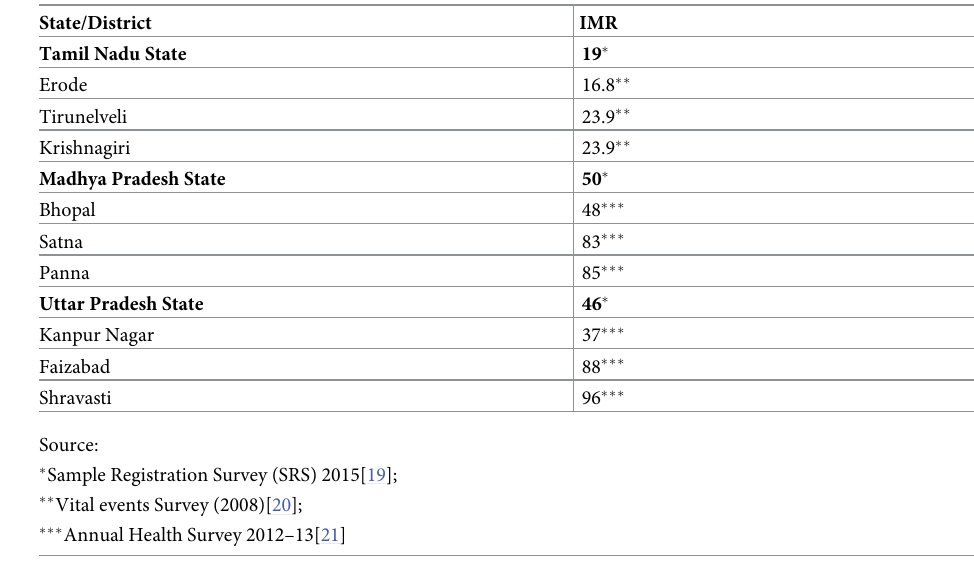
Table 1. Selected states/districts and their